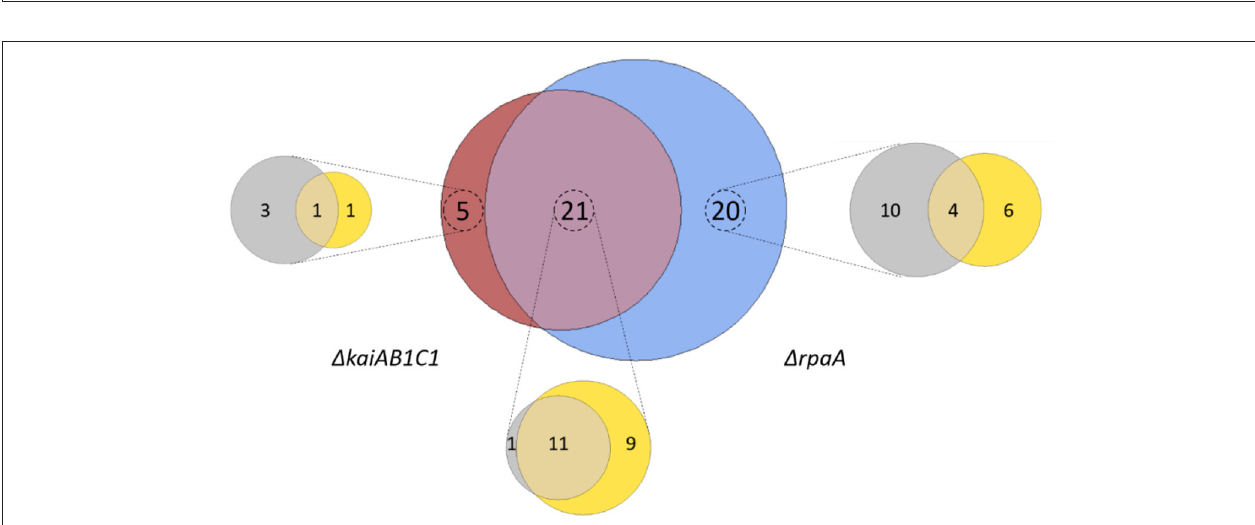
FIGURE 5 | Supplementary Table 1 . The grouping of the metabolites into the L/D response groups (L/D groups) was performed according to the changes in the wild type (L/D group I-II) and considered inverted (L/D group III-IV) changes in the mutants or emergent changes (L/D group V). Heat map: light yellow, low abundance; dark yellow, high abundance; gray, undetectable.